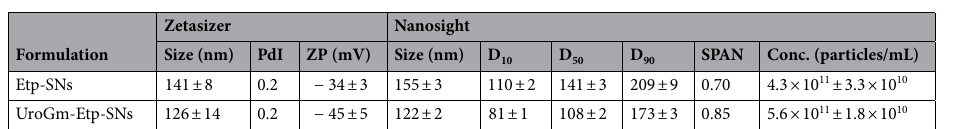
Figure 4. Confocal microscope images showing the internalization of SNs and UroGm-SNs in SW620 cells after 15 min, 1 h and 4 h of incubation. Green channel: TopFluor-sphingomyelin (TopFluor-SM) labelled nanosystems. Blue channel: nuclei stained with Hoechst.